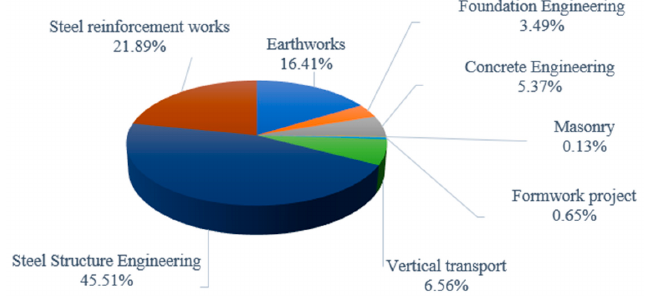
Figure 4. Carbon emission composition of the terminal building division project.